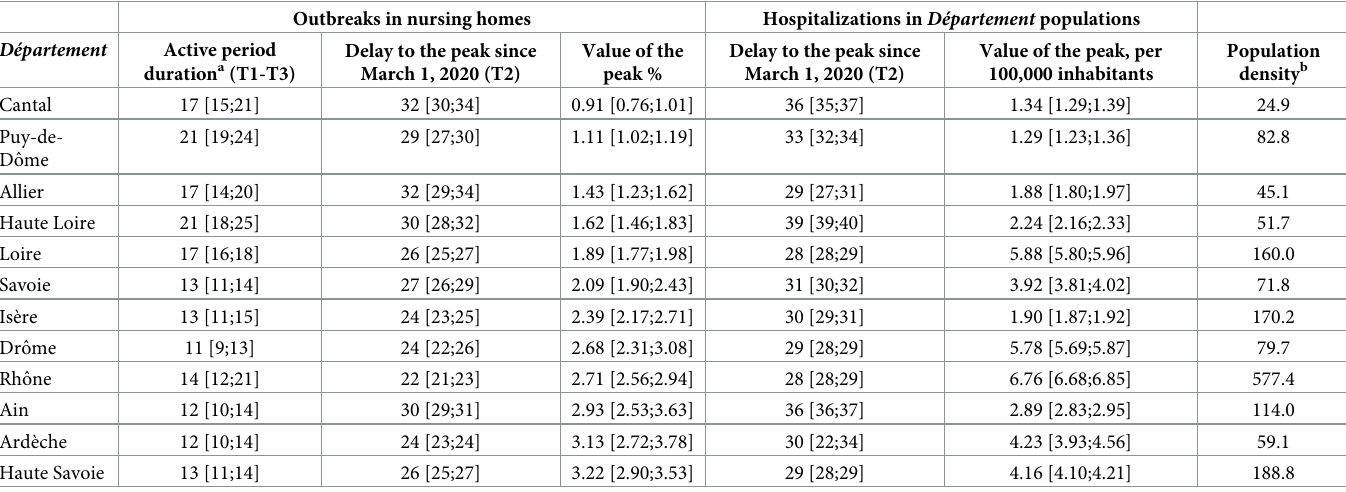
Table 2. Estimated durations of the active periods of COVID-19 outbreaks in nursing homes, estimated delays and values of the outbreak probability peaks in the nursing homes and the hospitalization probability peaks for COVID-19 in the populations of Auvergne-Rhoˆne-Alpes Region Départements , France, March 1–July